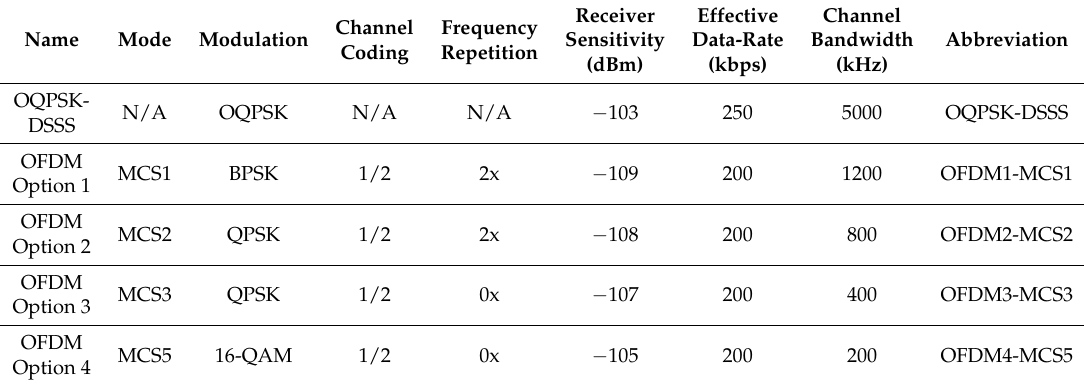
Figure 3. Evaluation setup. Note that the grey box around the transmitter, interferer and receiver devices represents an RF shielding enclosure used to ensure that communication between devices can only occur through the RF coaxial cables. Table 2. IEEE 802.15.4-2015 modulations that have been selected in this study to evaluate their robustness against